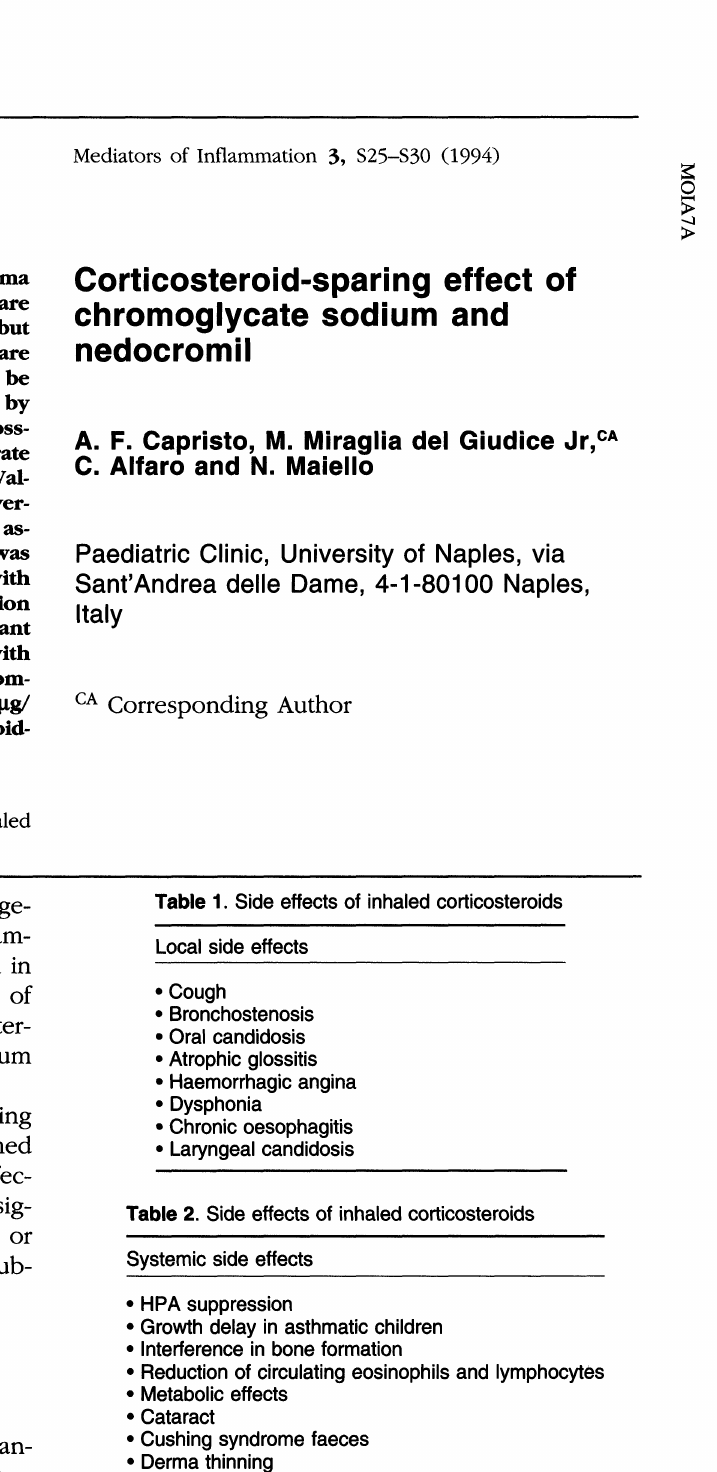
Table 2. Side effects of inhaled corticosteroids Systemic side